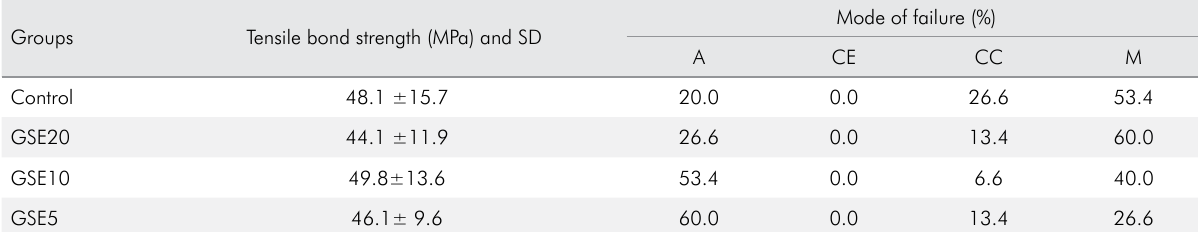
Table 1. Mean enamel tensile bond strengths ± standard deviation (SD) and mode of failure (%). Groups